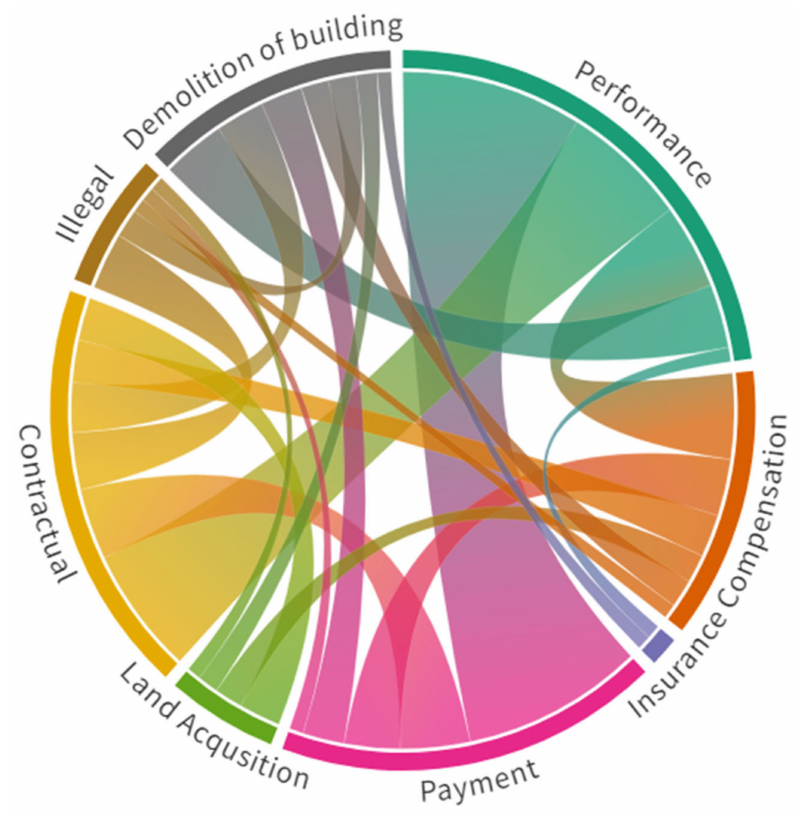
Figure 2. Chord diagram representation of correlation of various causes of disputes. Table 6. KMO and Bartlett’s